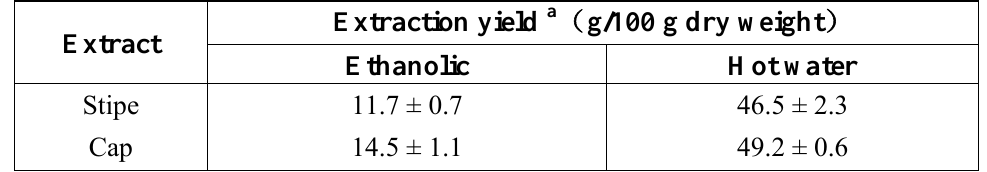
Table 1. Extraction yield of various extracts from C. comatus